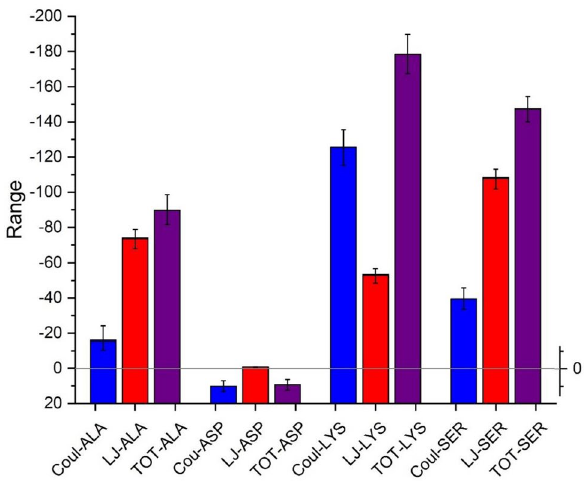
Figure 3. The average coulombic, van der Waals, and total interaction energies between different components of the studied systems and the error bars represent the standard deviations of the data.